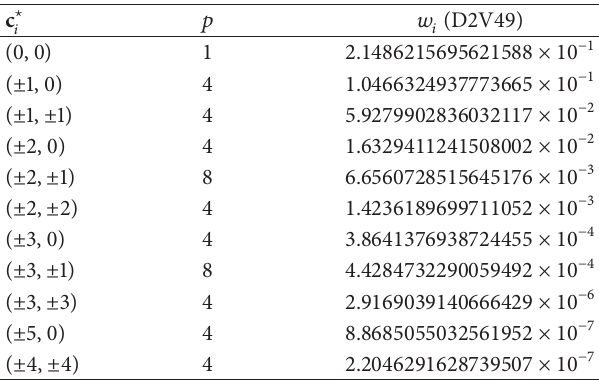
Table 1: Specification of a fifth-order lattice-Boltzmann stencil: 𝑎 𝑠 = 1.148732248838539 . The second column indicates the number of velocity vectors, obtained by permutating the vector components, sharing the given